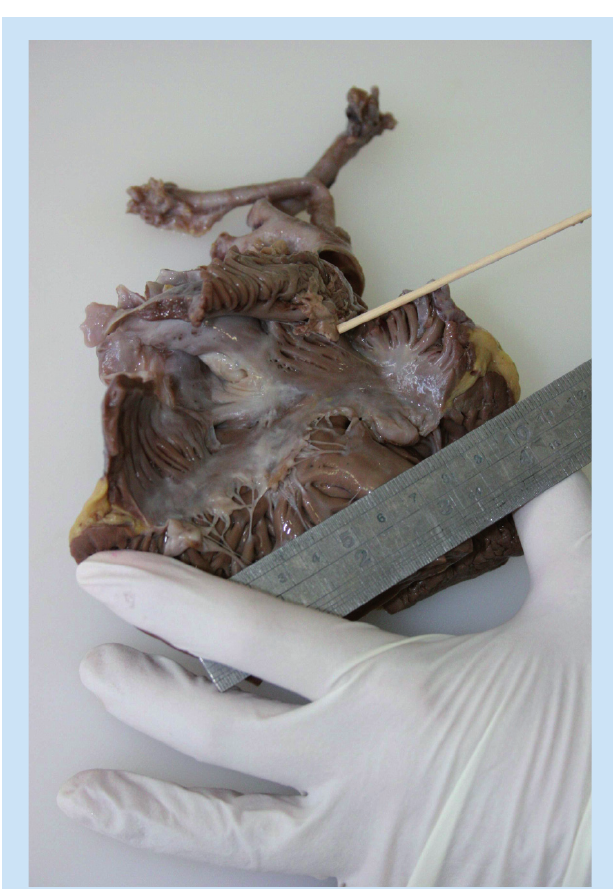
Fig. 7. Postmortem specimen showing thrombus in right ventricle.